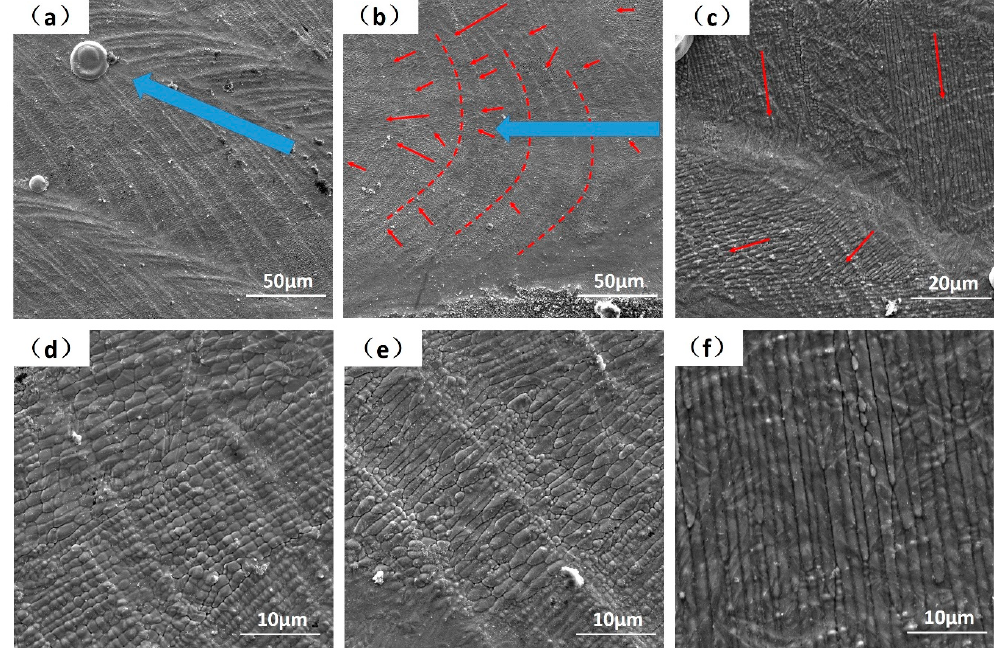
Figure 2. Top views of the single-layer powder laser melted top surface, observed at SEM with 1000× ( a , b ) and 2000× ( c ) magnification. The blue arrows demonstrate the scanning direction. The red dashed lines demonstrate the laser melt pool boundaries, the red arrows demonstrate the complex melt flow directions; Mixed hexagonal, pentagonal and square cellular patterns are shown in ( d ), elongated drifting cellular patterns in ( e ) and strip flow patterns in ( f ), observed with 5000×.